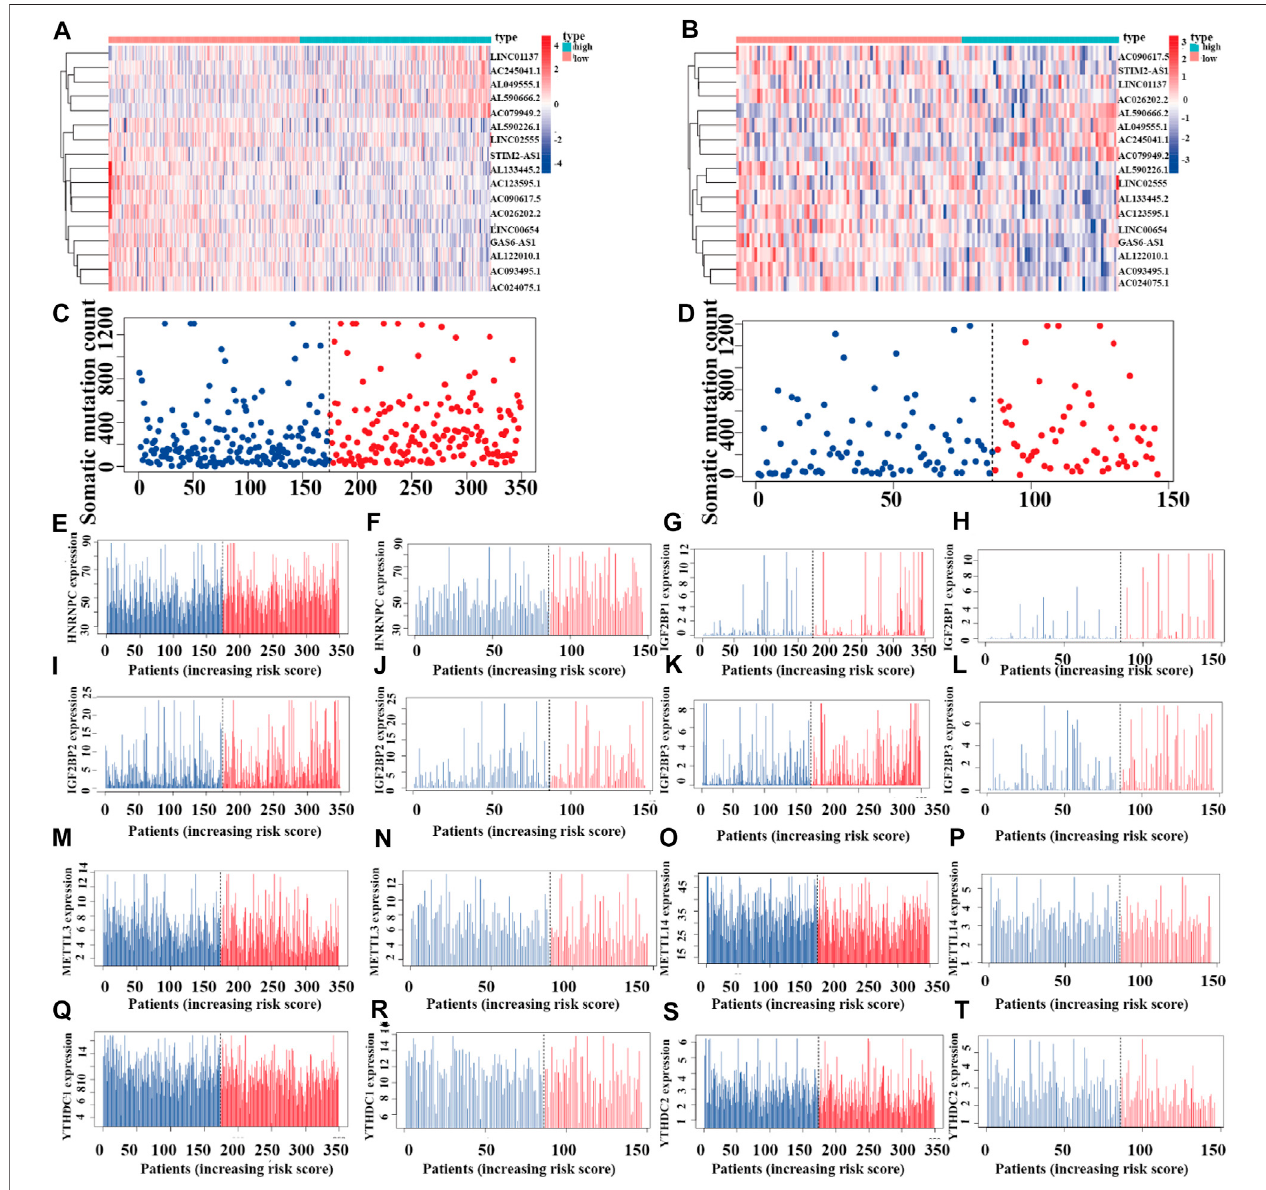
FIGURE 11 | Riskplot analysis of m 6 A-related regulators (A,C) Riskplot heatmap and somatic mutation counts for the prognostic model in the training cohort of LUAD patients. (B,D) Riskplot heatmap and somatic mutation counts for the prognostic model in the testing cohort of LUAD patients. (E,G,I,K,M,O,Q,S) Differences in expression of HNRNPC, IGF2BP1, IGF2BP2, IGF2BP3, METTL3, METTL14, YTHDC1, and YTHDC2 in the high- and low-risk groups of the training cohort. (F,H,J,L,N,P,R,T) DifferencesintheexpressionofHNRNPC, IGF2BP1,IGF2BP2,IGF2BP3,METTL3,METTL14,YTHDC1, andYTHDC2inthehigh-andlow-risk groups of the testing